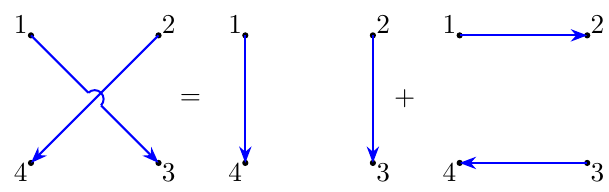
Figure 2 . Graphical representation of the relation [13][24] = [14][23] + [12][34] . Then Schouten identities are equivalent to untying crossings for both the two kinds of edges (red and blue) in the